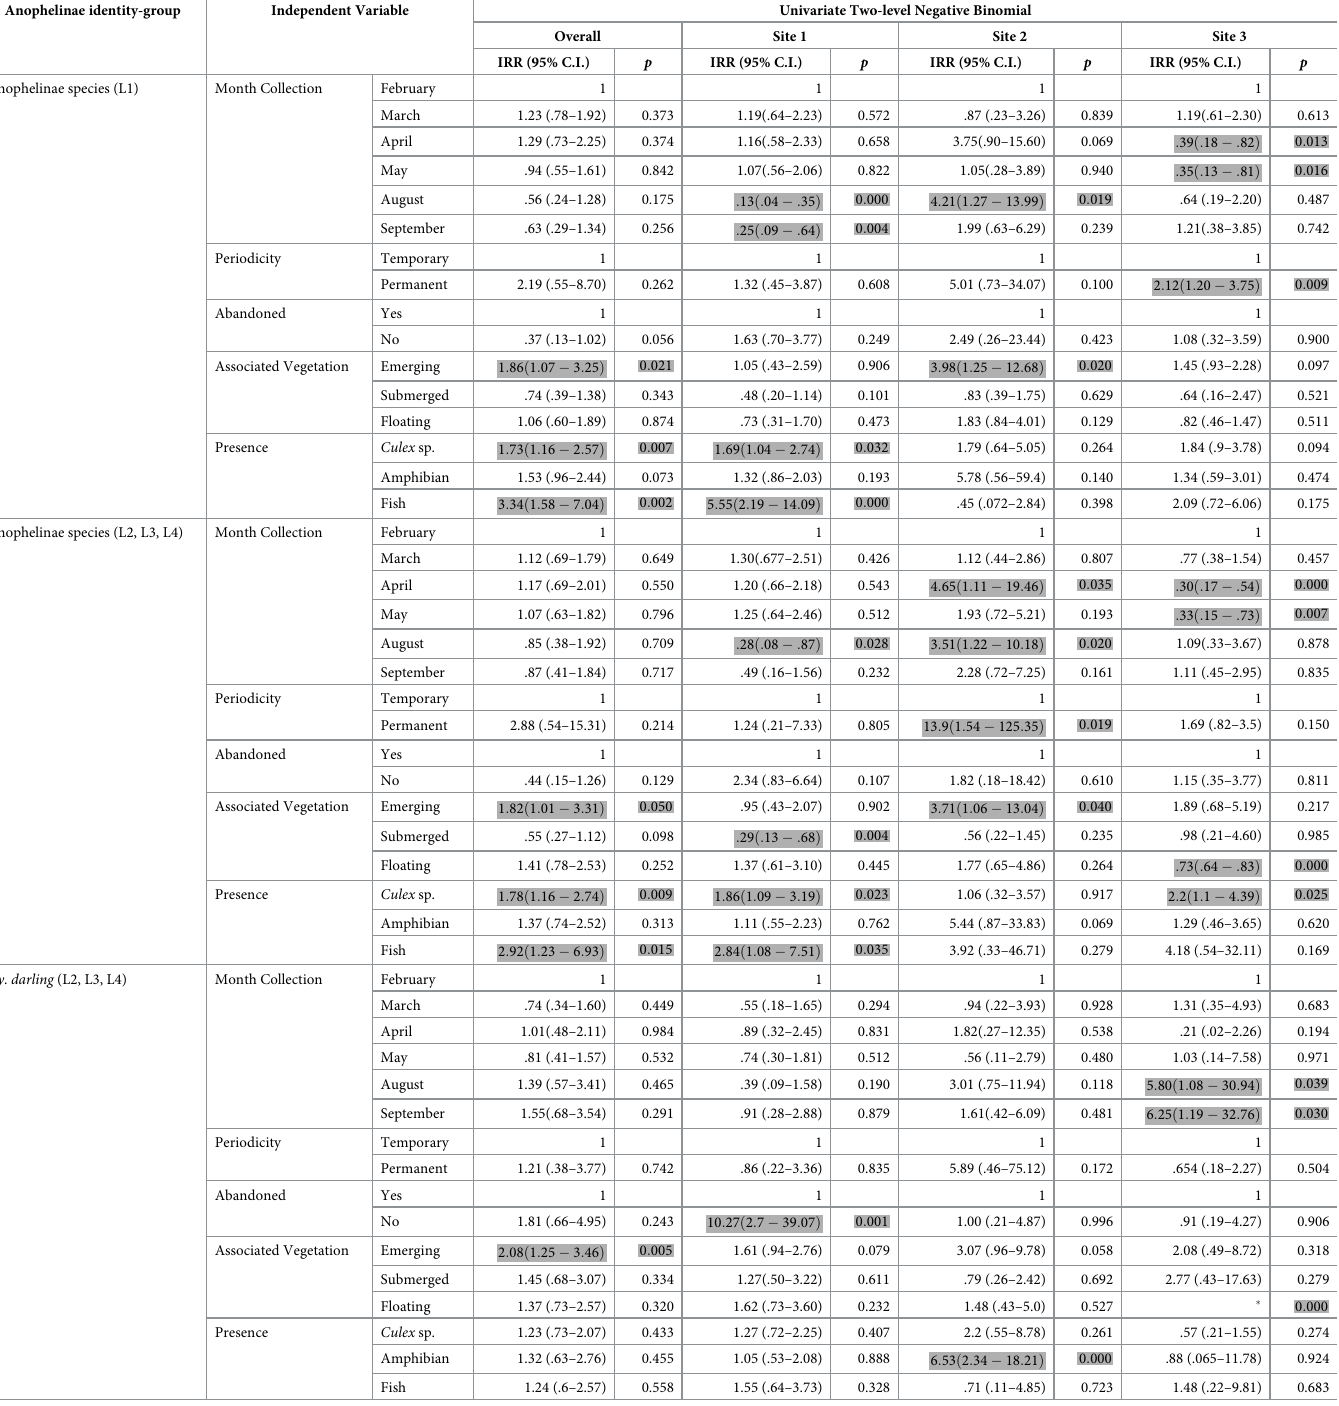
Table 1. Incidence Rate Ratio (IRR), 95% Confidence Interval and p values for Anophelinae identity-group, for six month survey univariate two level negative bino- mial regression.